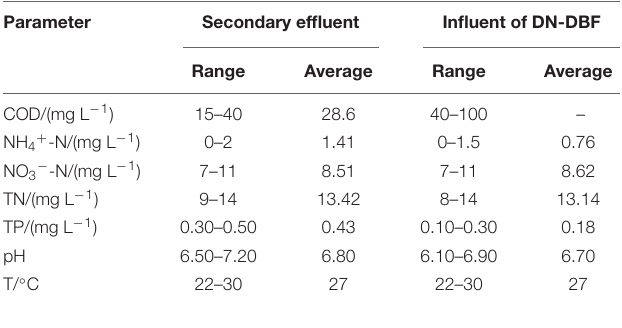
TABLE 1 | Main characteristics of influent